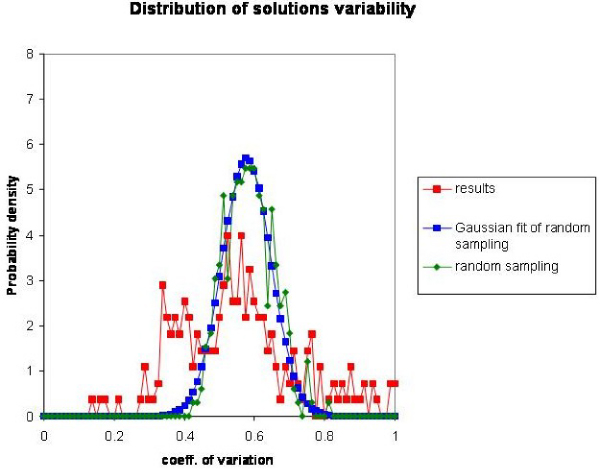
Distribution of the coefficients of variation of solution parameters. The coefficient of variation StdDev(log10Ki)/Mean(log10Ki), where {Ki}i = 1...n is any kinetic parameter, was computed for every parameter across the entire ensemble of solution sets. Their distribution is shown (red line). For comparison the distribution of the coefficient of variation of a variable X is shown (green line), where X is sampled from a uniform distribution in the interval [-5,0]. The distribution of the coefficient of variation can be approximated by a Gaussian density function N(μ, σ) with μ = 2/ and σ = 0.07 (in blue): the μ value is the coefficient of variation of the uniform distribution, while σ is the standard deviation of a random set of coefficients of variation obtained by sampling the uniform distribution in the interval [-5,0] (Fig. 7). A coefficient of variation smaller than 0.33 has a probability of random occurrence ≤ 0.0002, while the 17 parameters selected using the genetic algorithm represent 6.5% of the whole (Fig. 7), that is a coefficient of variation smaller the 0.33 have a proability of occurrence of 0.065 in the solution set.